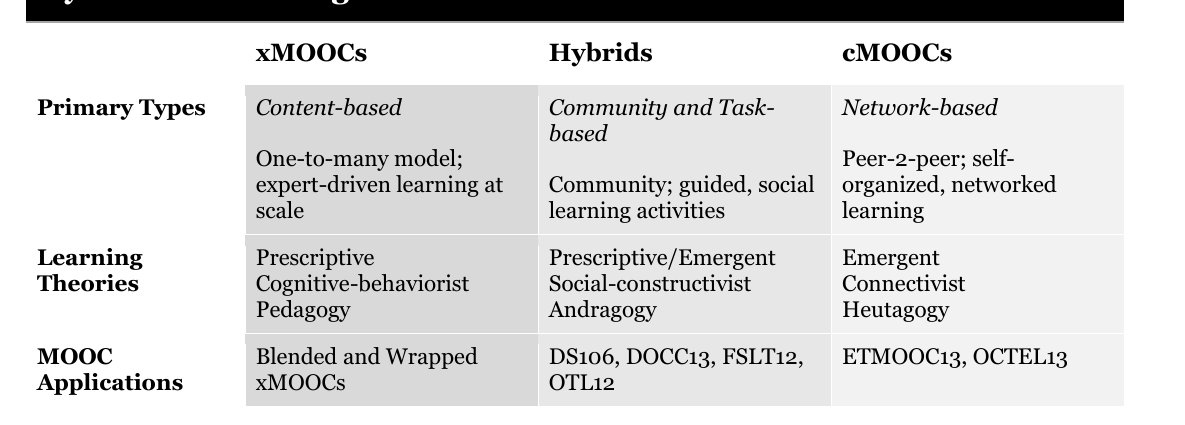
A Taxonomy of Hybrid MOOC Design Hybrid MOOC